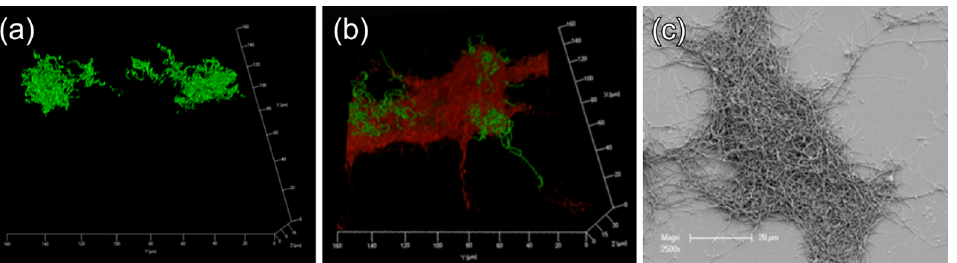
Figure 3. P.gingivalis W50ABK biofilm development. (a) 3D rendered confocal fluorescence image of P. gingivalis W50ABK homotypic biofilm stained with Syto 9 DNA dye. (b) 3D rendered confocal fluorescence image of a representative polymicrobial biofilm containing P. gingivalis W50ABK, T. denticola and T. forsythia , harvested at 90 h. Bacterial cells were stained with species-specific FISH probes (red, T. denticola ; green, P. gingivalis ). (c) SEM image of a representative gold-coated P. gingivalis W50ABK, T. denticola and T. forsythia polymicrobial